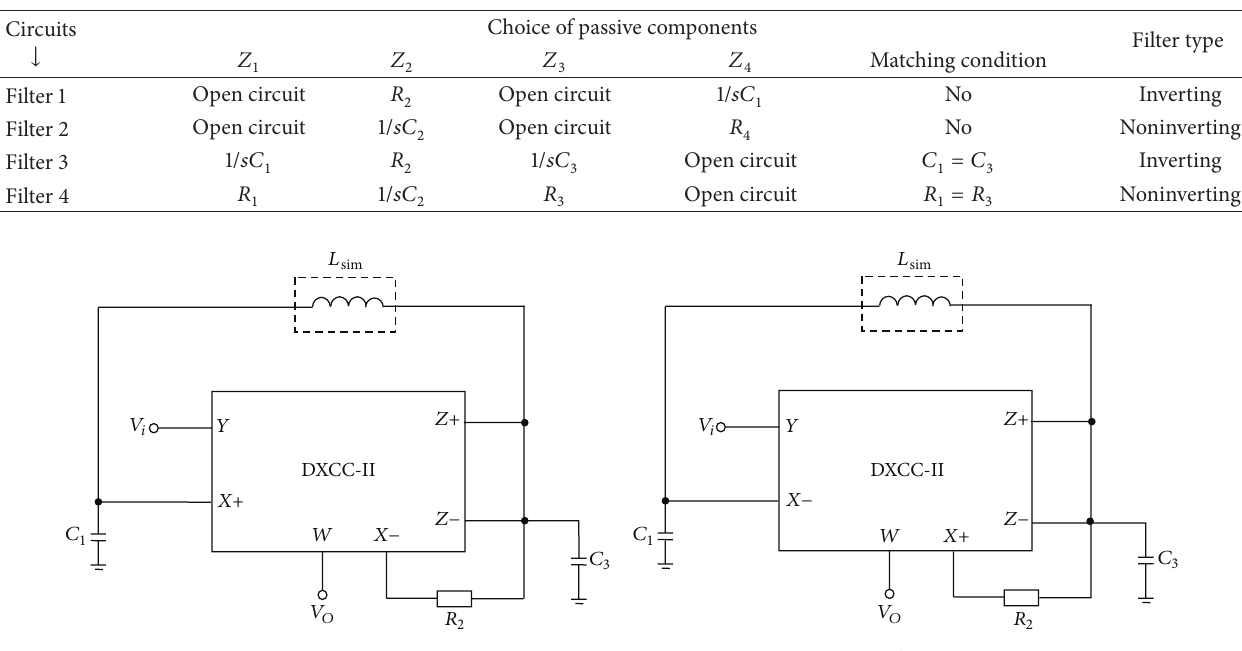
Figure 3: (a) Proposed second-order all-pass filter using simulated inductor. (b) Another circuit obtained by interchanging 𝑋 ports.